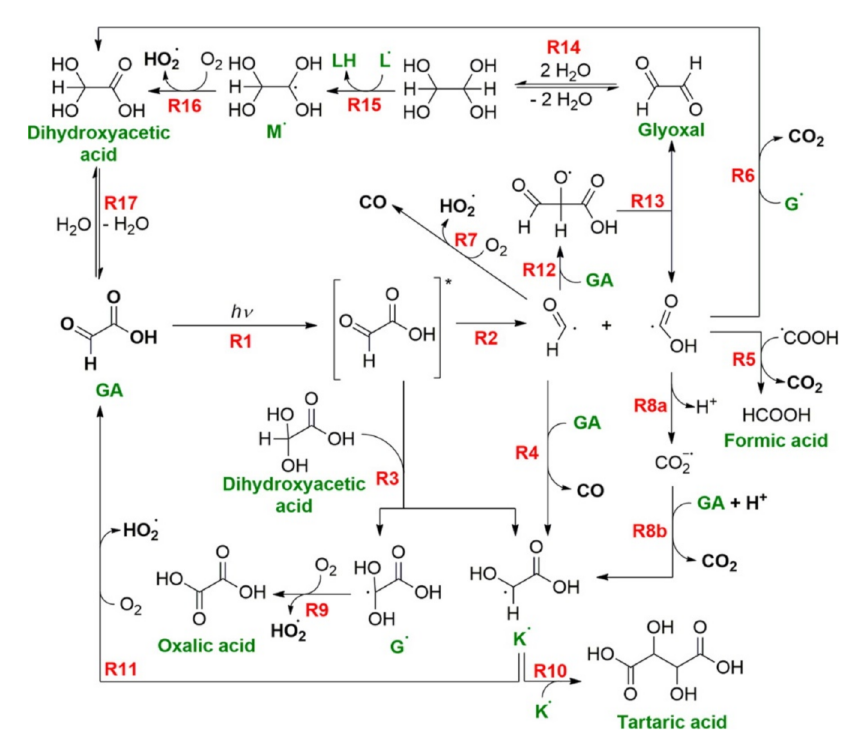
Scheme 4. Detailed mechanism for the photooxidation of GA at λ ≥ 305 nm in Water, reproduced with permission from ref.